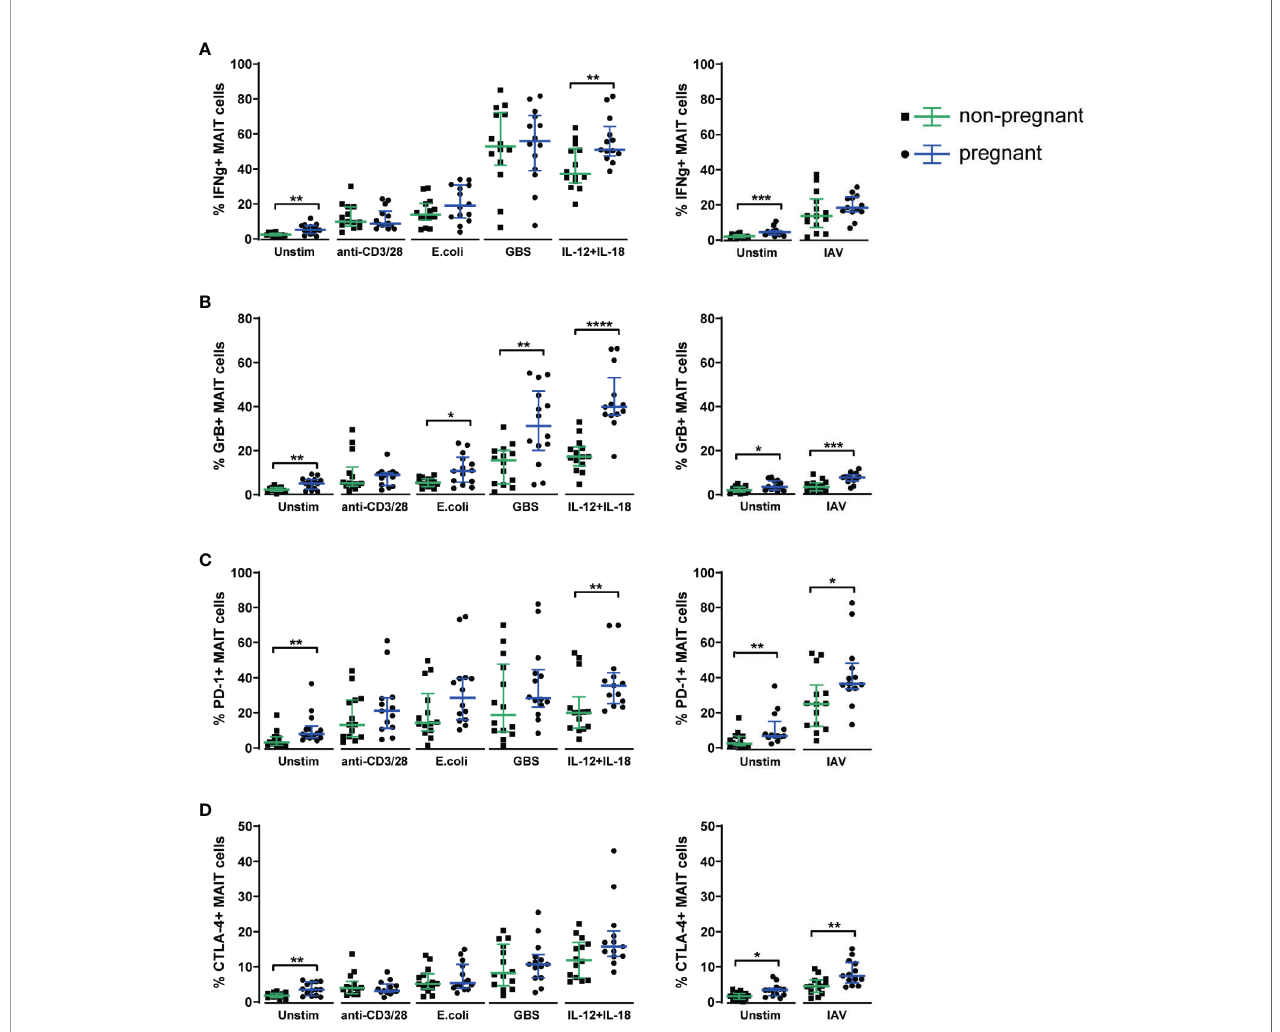
FIGURE 5 | Circulating MAIT cells from 3 rd trimester pregnant women exhibit a stronger functional response upon stimulation with microbial and in fl ammatory stimuli compared with MAIT cells from non-pregnant women. PBMCs isolated from the blood of 3 rd trimester pregnant women (n=14) and from non-pregnant, age- matched controls (n=14) were stimulated overnight with plate-bound anti-CD3 and anti-CD28 antibodies, fi xed E coli , fi xed group B streptococci (GBS), a combination of IL-12 and IL-18, with in fl uenza A virus (IAV) or left unstimulated (Unstim). IAV stimulations were carried out in a separate plate, together with a separate unstimulated control. MAIT cells in unstimulated and stimulated samples were analyzed for their expression of (A) IFN g , (B) granzyme B (GrB), (C) PD-1 and (D) CTLA-4. For PD-1, cell surface expression was analyzed, whereas IFN g , granzyme B and CTLA-4 were stained intracellularly. Results for CD69 from the same experiments are shown in Supplementary Figure S6B . Bars show median and IQR and statistical comparisons between the non-pregnant and pregnant group were performed using Mann-Whitney test. * p < 0.05, ** p < 0.01, *** p < 0.001, **** p < 0.0001. n = 13-14 for both